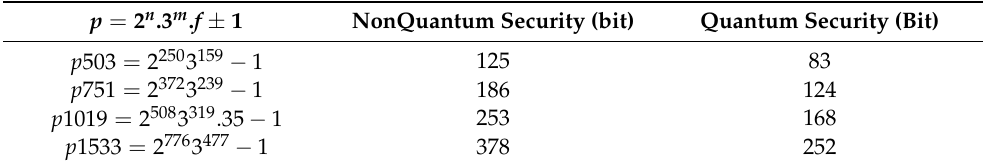
Table 3. Public parameters with comparative nonquantum and quantum security (bits).